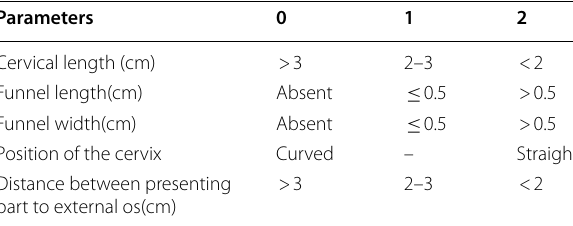
Table 1 TVS (Transvaginal Ultrasound) score by Bajpai et al. [4]